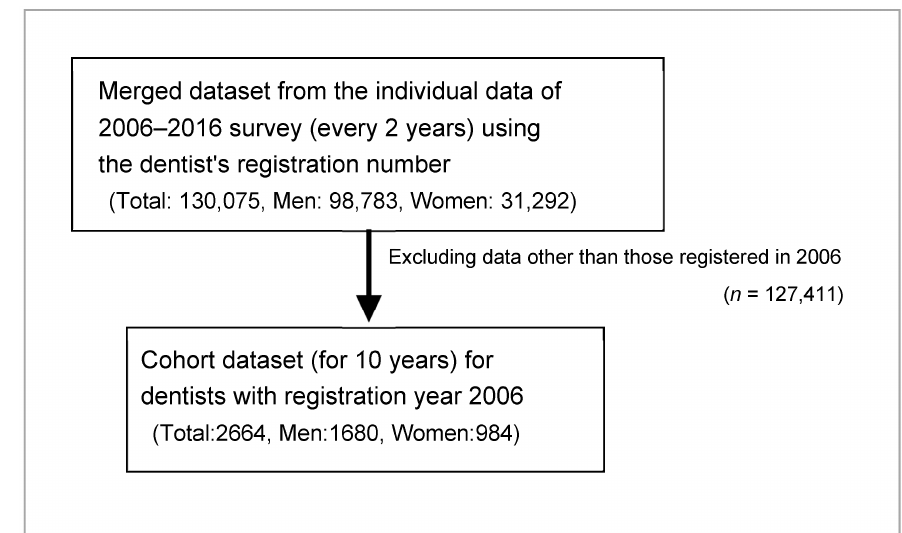
Figure 1. Method of acquisition and preparation of data of the study participants.